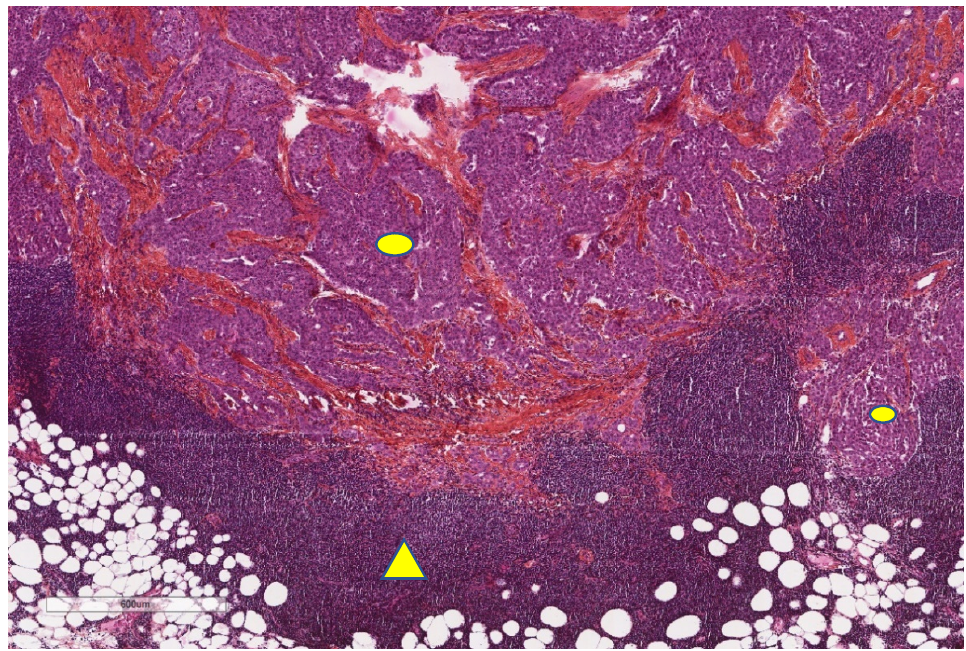
Figure 4. Important infiltrate of lymphocytes (triangle) surrounding tumour (ovals) in the same case of malignant mesothelioma shown in Figure 3 (X40) . of malignant mesothelioma shown in Figure 3